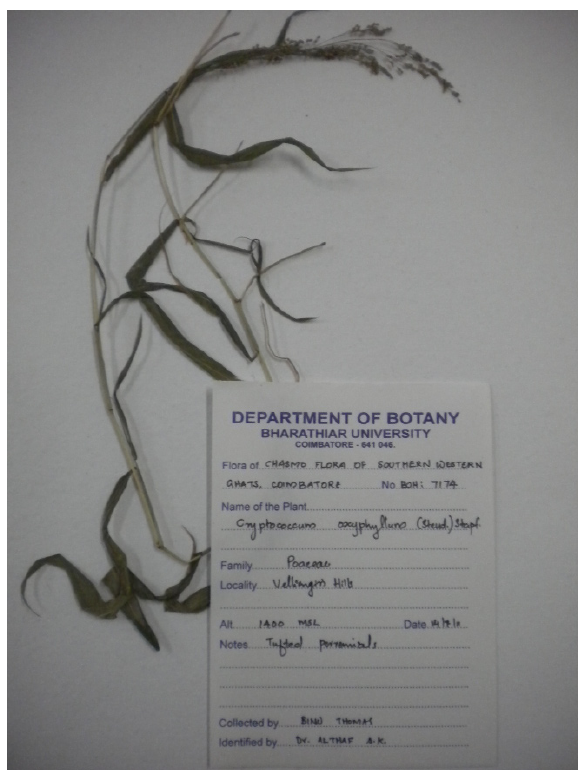
Image 12. Centotheca lappacea (L.) Desv.